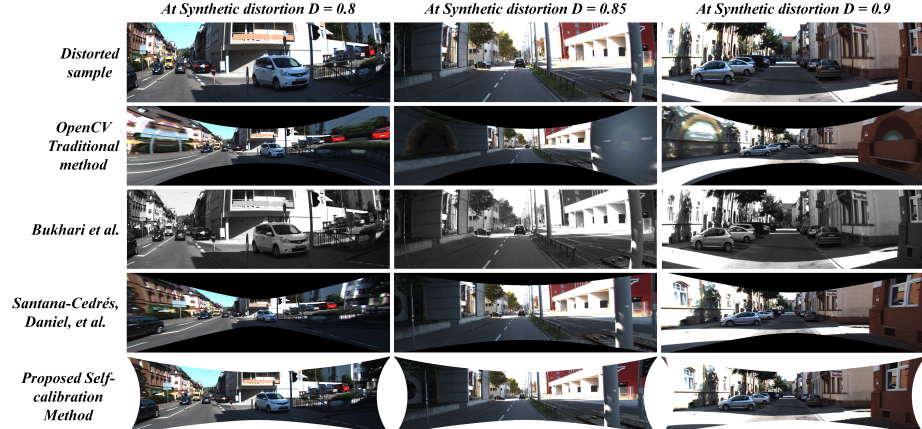
Figure 17. Comparison between proposed method against contemporary self-calibration and OpenCV traditional algorithms on Synthetically distorted KITTI data (D = 0.8 ∼